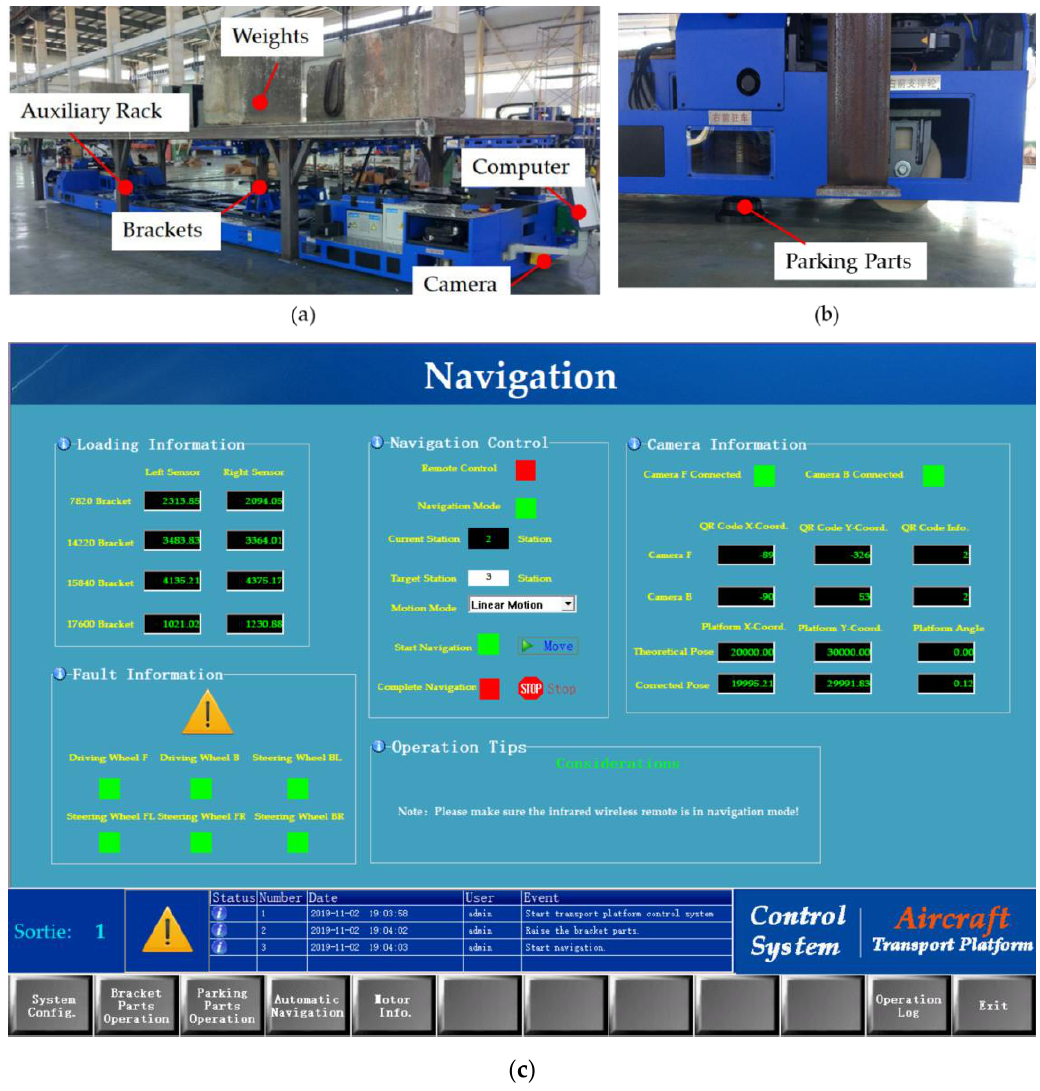
Figure 12. Navigation experiments in a workshop: ( a ) weights distribution; ( b ) parking situation; and ( c ) software interface. Table 4. Theoretical and actual positions and postures at each station of the first